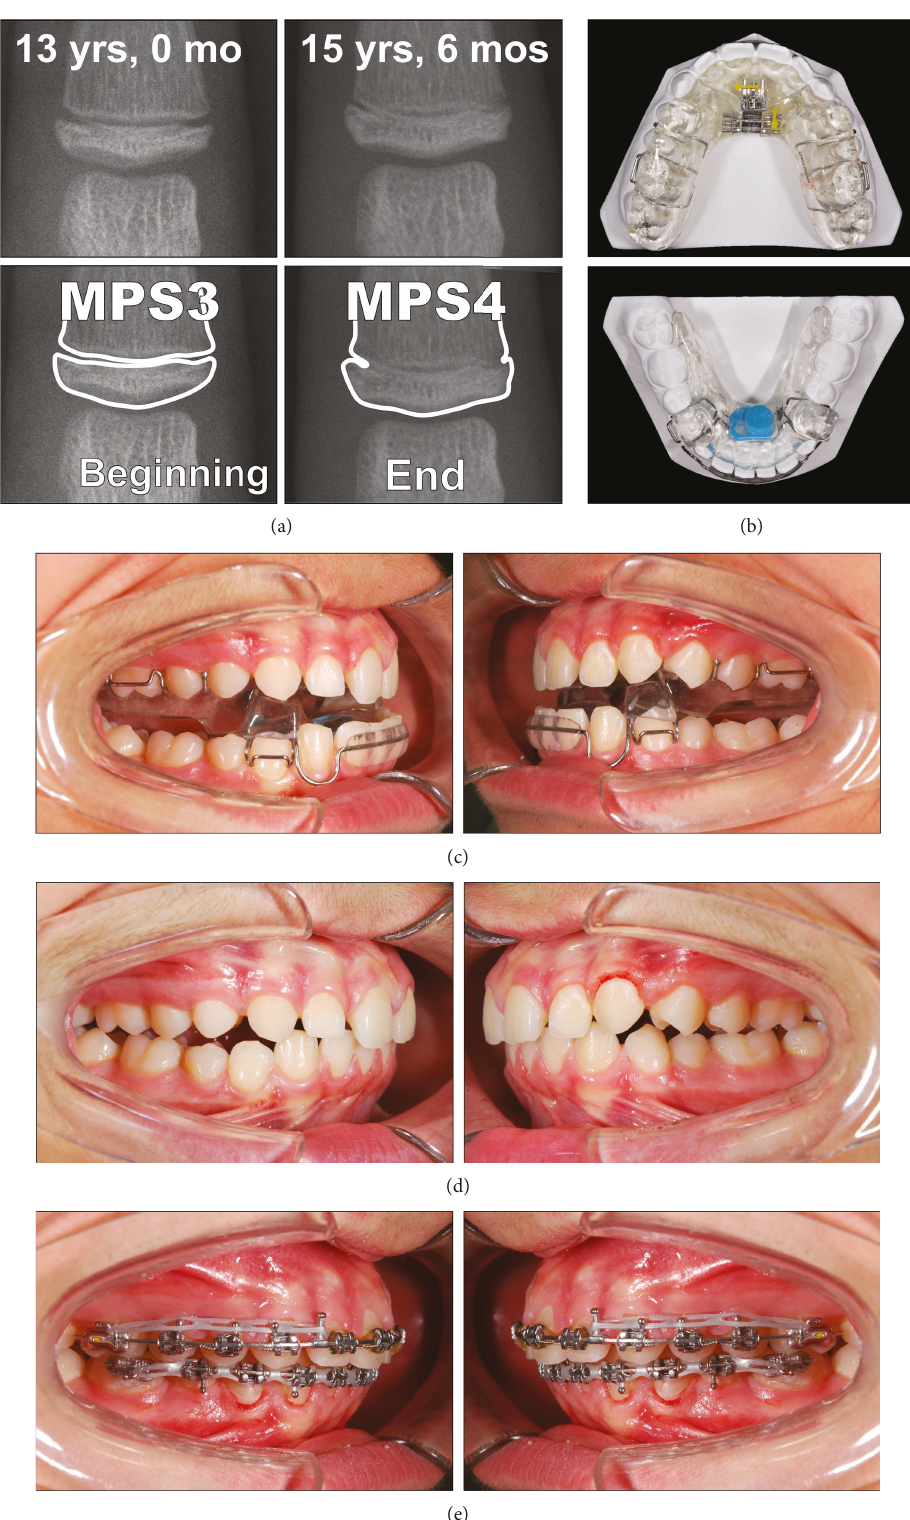
Figure 11: Case 3. (a) The MPM recordings with corresponding ages and according to the timing of functional treatment (beginning and end of treatment). (b) Occlusal views of the modi fi ed Twin-Block appliance. (c) Intraoral views of the modi fi ed Twin-Block appliance. (d) The full- fi xed